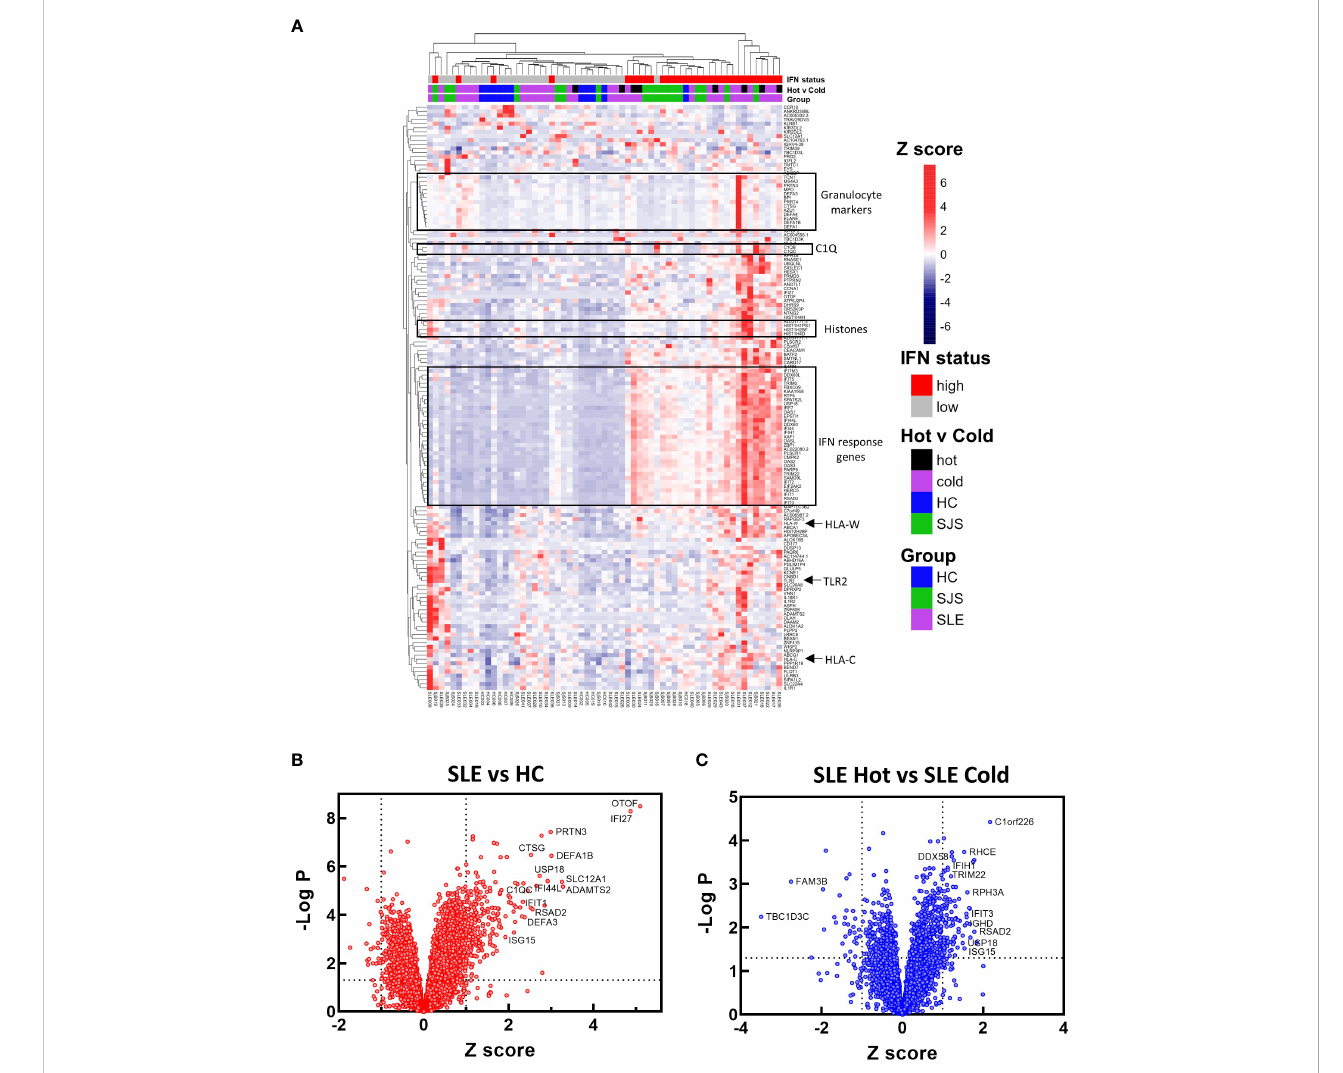
FIGURE 5 RNA-seq gene expression analysis. RNA-seq gene expression analysis was performed on blood samples from HCs, SjS, and SLE subjects. (A) Gene expression data is presented in a heat map as normalized expression to show comparisons for SLE versus HC or SLE ‘ cold ’ versus SLE ‘ hot ’ . (B, C) Volcano plots were constructed for differential expression comparisons and dotted lines show a Z score cutoff of 0.7 and a p value cutoff of 0.01 and notable gene changes are labeled. HCs, healthy controls; SLE, systemic lupus erythematosus; SjS, Sjogren ’ s syndrome.